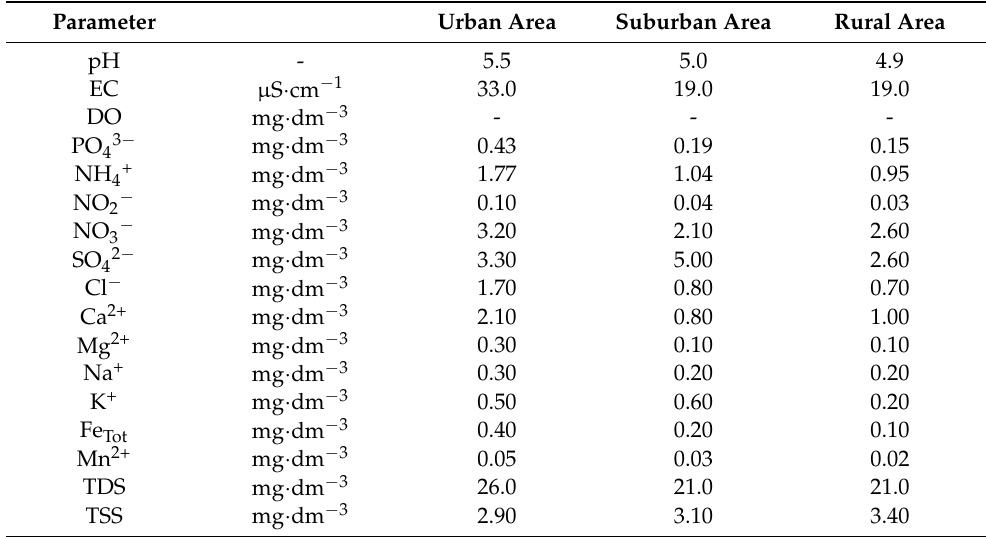
Table 2. Average levels of physical and chemical indices for rainwater in studied catchments.